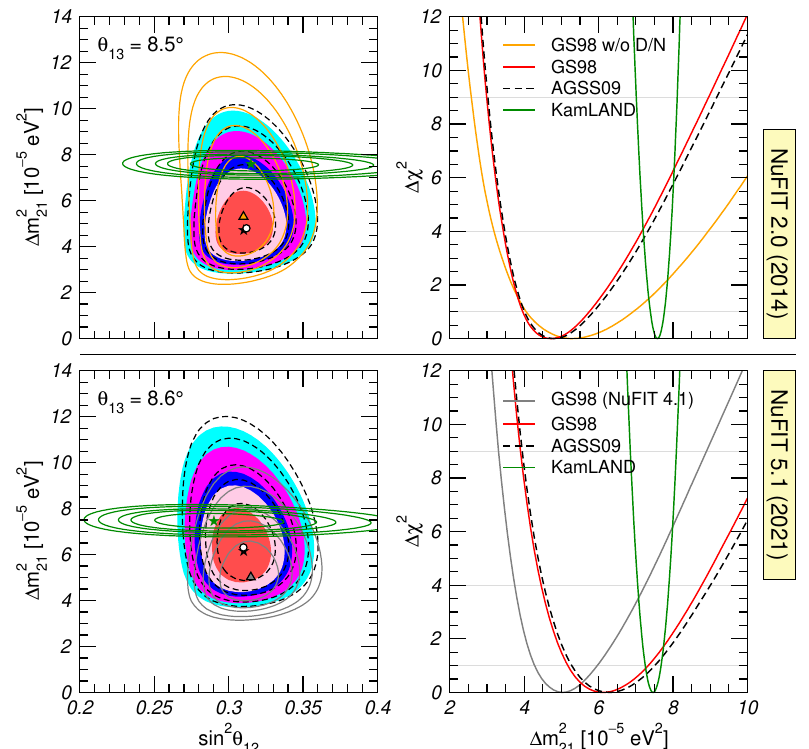
Figure 3. ( upper-left ) NuFIT 2.0 allowed parameter regions (at 1 σ , 90%, 2 σ , 99% and 3 σ CL for 2 d.o.f.) from combined analysis of solar data for GS98 model (full regions with best fit marked by black star) and AGSS09 model (dashed void contours with best fit marked by a white dot), and analysis of KamLAND data (solid green contours with best fit marked by a green star) for fixed θ 13 = 8.5 ◦ . Orange contours are the results of a global analysis for the GS98 model but without including day–night information from SK. ( upper-right ) NuFIT 2.0 ∆ χ 2 dependence on ∆ m 2 for the 21 same four analyses after marginalising over θ 12 . ( lower-left ) Same as upper-left but for NuFIT 5.1 and fixed θ 13 = 8.6. Previous results of global analysis for GS98 model in NuFIT 4.0 shown as orange contours [35]. ( lower-right ) ∆ χ 2 dependence on ∆ m 2 for same four analyses as the lower-left panel 21 after marginalising over θ 12 . Figure adapted from